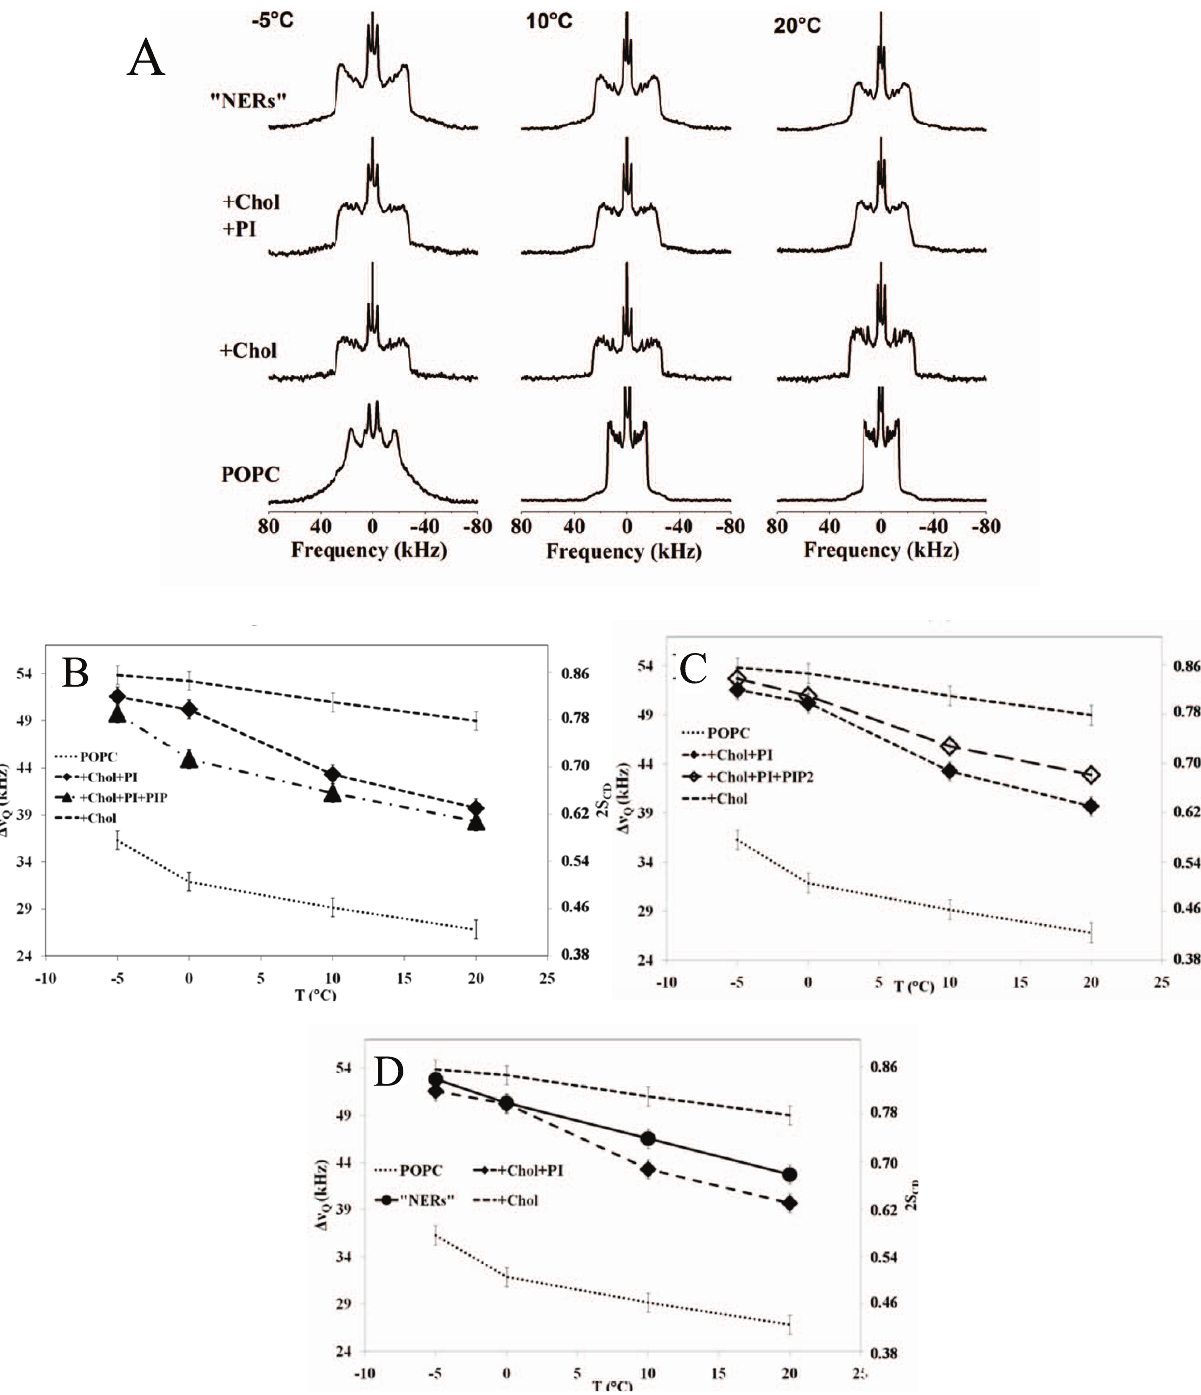
Figure 2. Core fluidity of PtdCho/Chol/PtdIns model membranes deuterium wide-line NMR spectra. A -Representative deuterium wide-line NMR spectra of POPC- 2 H with cholesterol in the absence or presence of different PtdIns. The molar ratios are representative of the lipid composition found in NER: POPC/Chol (58/42), POPC/Chol/PtdIns (28/42/30), and NERs-like membranes POPC/Chol/PtdIns/PtdIn s P/PtdInsP 2 (28/42/23/16/7/7). Temperatures are indicated on the spectra. Sample hydration (water mass/water + lipid mass) is 95%. Depending on deuterated POPC amounts (1– 3 mg), each spectrum is the result of 10 k to 100 k cumulative scans. A Lorentzian filtering (LB) of 200–300 Hz was applied prior to Fourier transformation. FIG. 2B–D . Orderingof chainsegmentsclose to glycerol backbone,NER-like membranes. Thermal variationof the plateau (k=2 to 8–10) quadrupolar splittings of POPC/Chol/PtdIns (28/42/30) and POPC/Chol/PtdIns/PtdIn s P (28/42/23/7), panel B; POPC/Chol/PtdIns (28/42/30) and POPC/ Chol/PtdIns/PtdIn s P 2 (28/42/23/7), panel C: POPC/Chol/PtdIns (28/42/30) and NERs-like model membranes POPC/Chol/PtdIns/PtdIn s P/PtdInsP 2 (28/42/ 23/16/7/7), panel D. For comparison, data for pure POPC and POPC/Chol (58/42) membranes was added to the graphs. Accuracy of the measure is 6 1 kHz. On the double Y-axis the corresponding Carbon-Deuterium order parameter is shown. Because the average orientation of all plateau C–D bonds is at 90 u with respect to the long lipid axis, twice |S CD | is plotted to express residual ordering information relative to the bilayer normal.